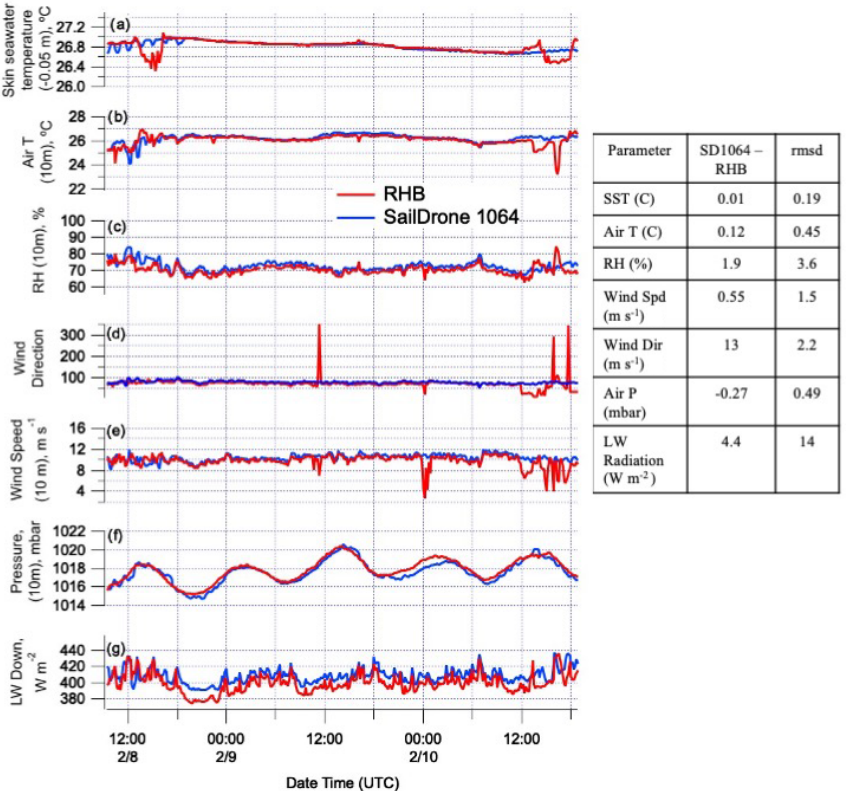
Figure 8. Comparison of parameters measured on board Saildrone 1064 (SD1064) and RV Ronald H. Brown ( RHB ) when the platforms were within 0.7 to 3.6nmi of each other between 8 and 10 February. Parameters include (a) SST (SD at − 0 . 05m and RHB sea snake), (b) air temperature (10m), (c) RH (10m), (d) wind direction, (e) wind speed (10m), (f) atmospheric pressure (10m), and (g) longwave downwelling radiation. Absolute differences (SD1064 − RHB ) and root mean square differences (RMSDs) are reported in the inset table. Number of samples based on 10min averaged data =